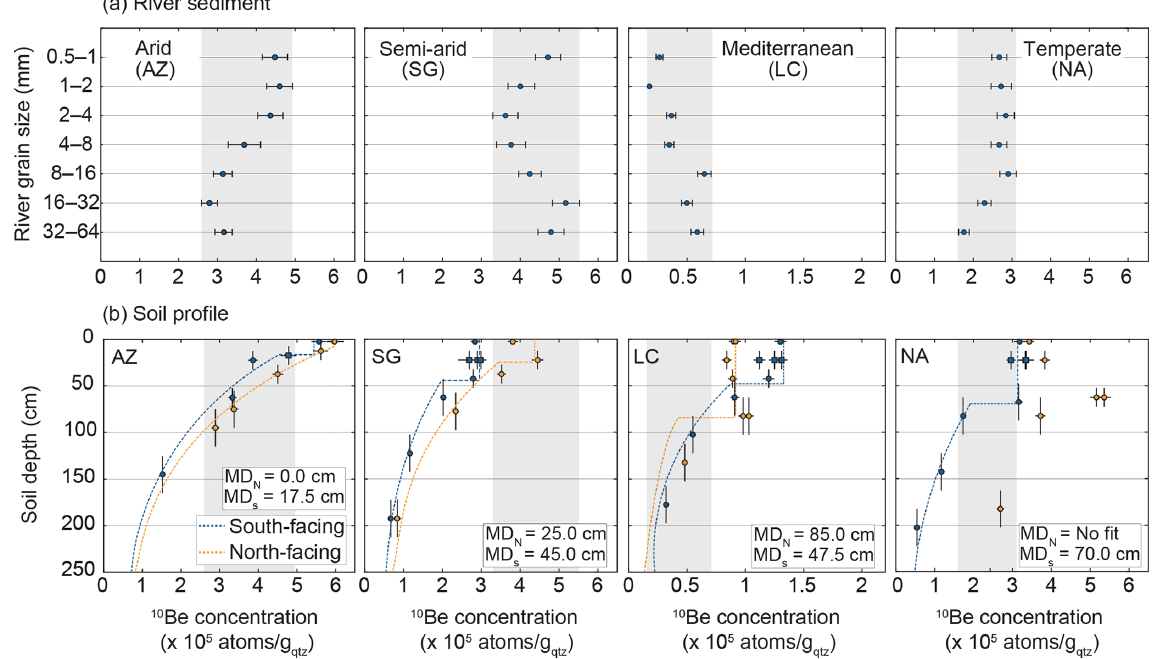
Figure 10. Comparison of 10 Be concentrations measured in (a) river sediment, and (b) north- and south-facing soil profiles (Schaller et al., 2018), from the same catchments in the Chilean Coastal Cordillera. MD N and MD S are the soil mixing depths of the north- and south-facing hillslopes, respectively. Note the reduced x axis range of the Mediterranean catchment (LC). Shaded areas show range of 10 Be concentrations in river sediment for comparison with soil